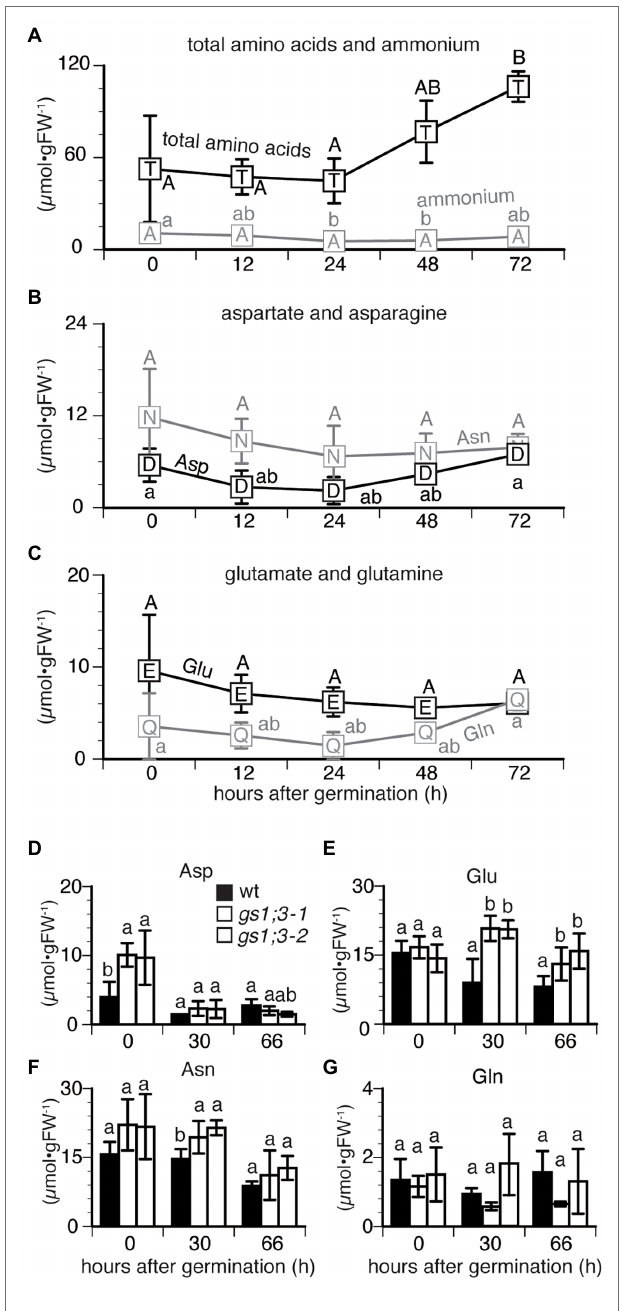
FIGURE 3 | Changes in the concentration of free amino acids and ammonium in germinating rice seeds. Concentrations of (A) total amino acids and ammonium and (B,C) four selected amino acids in Nipponbare (WT) seeds sampled at 0, 12, 24, 48, and 72 h after imbibition. Data represent mean ± SD ( n = 3–5). Mature seeds of WT and GS1;3 mutants harvested at 0, 30, and 66 h after imbibition (D–G) . Data represent mean ± SD ( n = 5). Significant differences within each group A–C , changes of each compound in different time and D–G , changes of compound at certain time point in different genotypes) were determined using one-way analysis of variance (ANOVA) followed by Bonferroni tests and are indicated with different letters ( p <